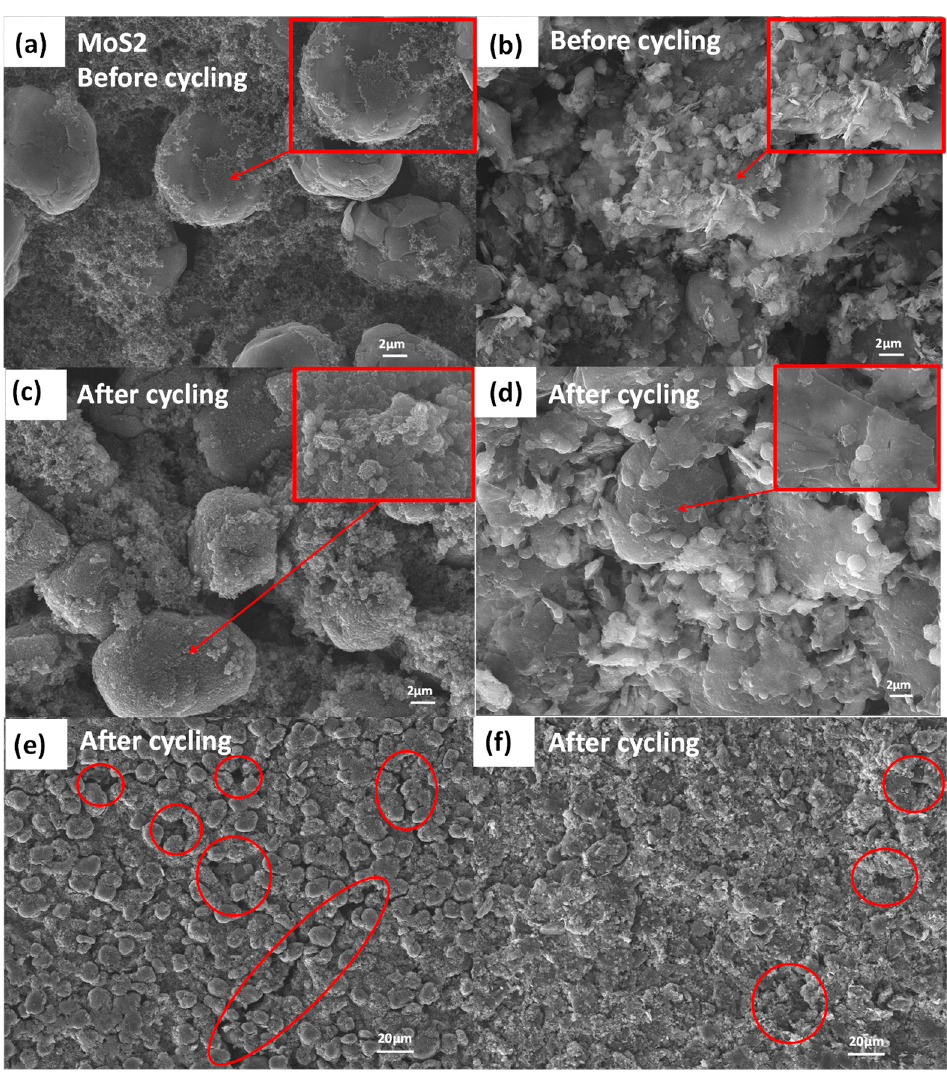
Figure 5. SEM image of the electrode before and after 300 cycles at 1C rate: ( a ) Graphite electrode before cycling; ( b ) MoS 2 /graphite electrode before cycling; ( c , e ) Graphite electrode after cycling; ( d , f ) MoS 2 /graphite electrode after cycling.